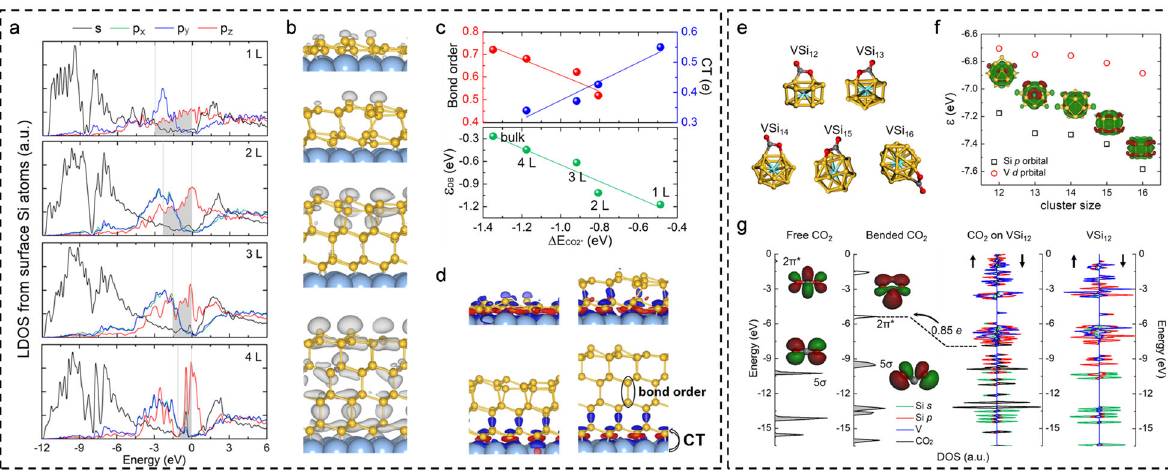
Fig. 4 Silicene on Ag(111) substrate for CO 2 hydrogenation. a LDOS from surface Si atoms in monolayer and few-layer silicene on Ag(111) projected onto various atomic orbitals. b Partial charge density distributions (gray colors) of the surface dangling bonds at Fermi energy. c Top panel: Si – Si bond order between neighboring silicene layers (red symbol) and electron transfer (CT) from the Ag substrate to silicene (blue symbol); bottom panel: energy levels of surface dangling bonds states ( ε DB ) as a function of CO 2 adsorption energy ( Δ E CO2* ). d Differential charge density distributions between the silicene sheet and Ag(111) substrate ( a – d are reproduced with permission from ref. 137 , Copyright © The Royal Society of Chemistry 2019). e Structures of VSi n clusters chemisorbed with a CO 2 molecule. f The p -orbital center ( ε p , black symbols) and coordination number (CN, red symbols) of Si atoms as a function of the cluster size. g From left to right: DOS of a free CO 2 molecule, bended CO 2 molecule, CO 2 chemisorbed on the VSi 12 cluster, and a standalone VSi 12 cluster, respectively ( e – g are reproduced with permission from ref. 140 , Copyright © American Chemical Society